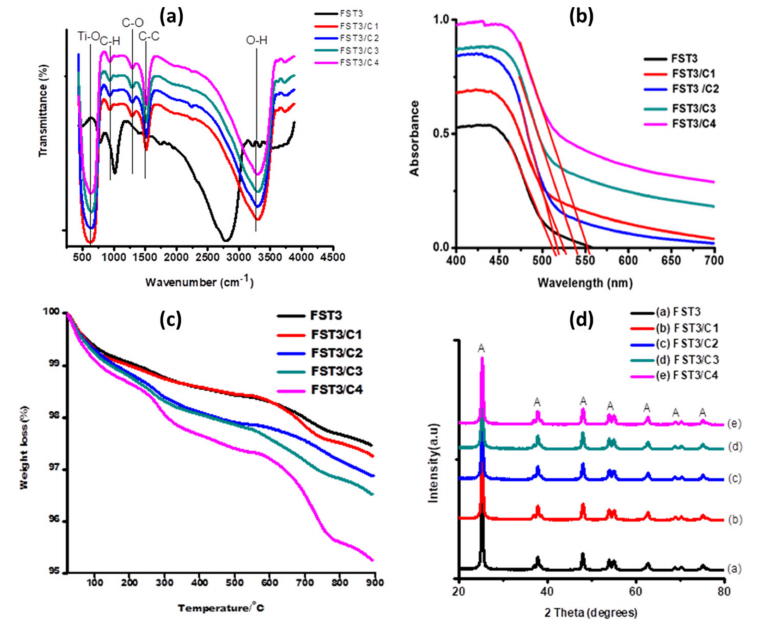
Figure 1. ( a ) FTIR spectra of different MWCNT loadings/F, Sm 3+ co-doped TiO 2 (0.6% Sm 3+ ); ( b ) UV- Vis spectra for FST3/MWCNT with different MWCNT loadings used for direct approximation